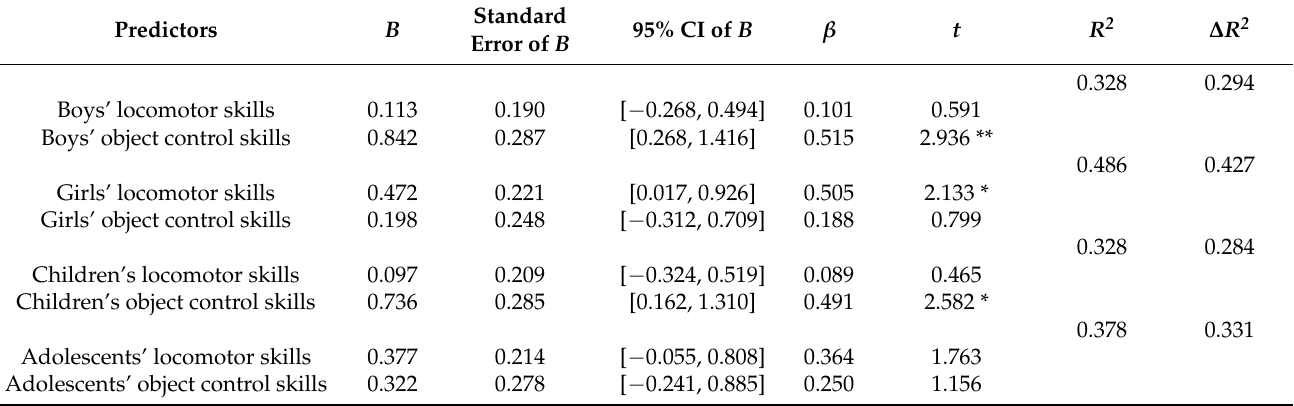
Table 7. Regression of MVPA for gender-specific/age-specific participants, including predictors, and